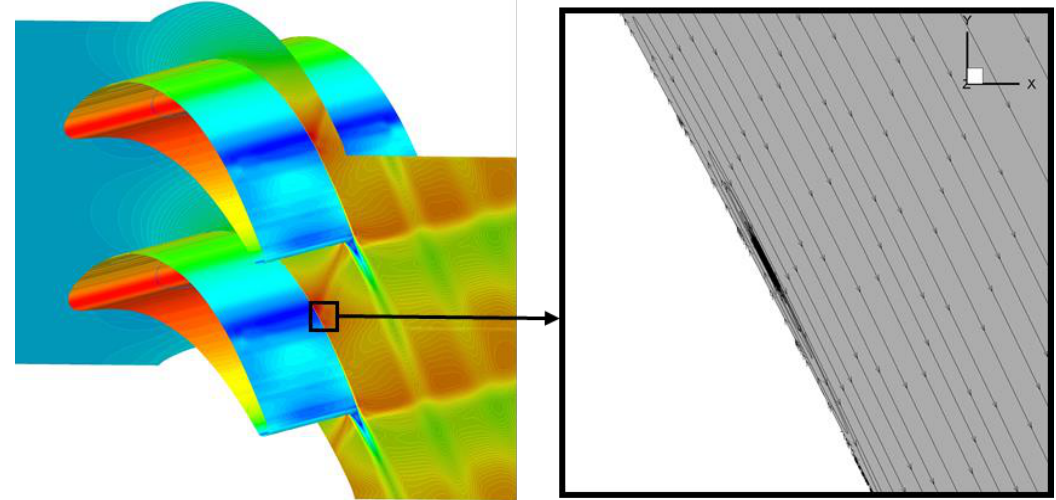
Figure 15. Local pressure and streamline distribution on the suction side.